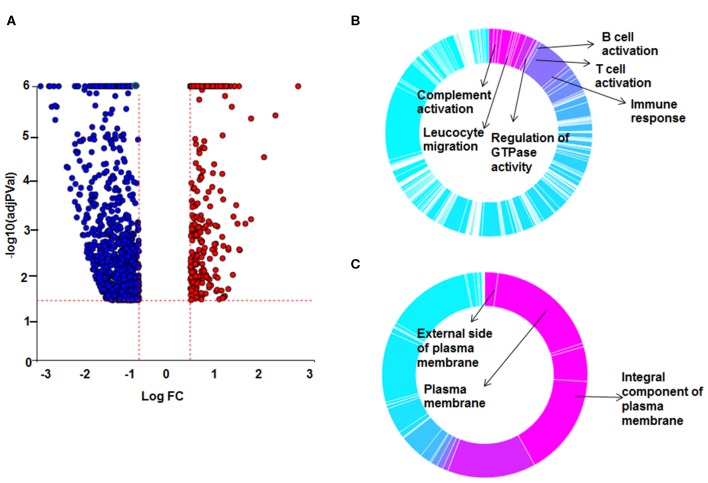
Differential gene expression and Gene Ontology (GO) processes between sarcoid DEX-treated and untreated sarcoid monocytes. (A) Volcano plot: All 1,958 significant DE genes analyzed by DEseq2 analysis tool are represented in terms of their measured expression fold change (log2FC) on x-axis and the significance of the change (–log10 adj p-value) on y-axis. The dotted lines represent the thresholds used to select the DE genes: log2 FC > 0.6 and significance FDR<5%. The up-regulated genes (positive log2FC) are shown in red, while the down-regulated (negative log2FC) genes are shown in blue. (B,C) Gene Ontology (GO) analysis of DE genes was done using ipathwayGuide analysis tool. To assess the enrichment of GO terms Elim pruning method was used. GO analysis identified top (B) biological processes and (C) cellular components.